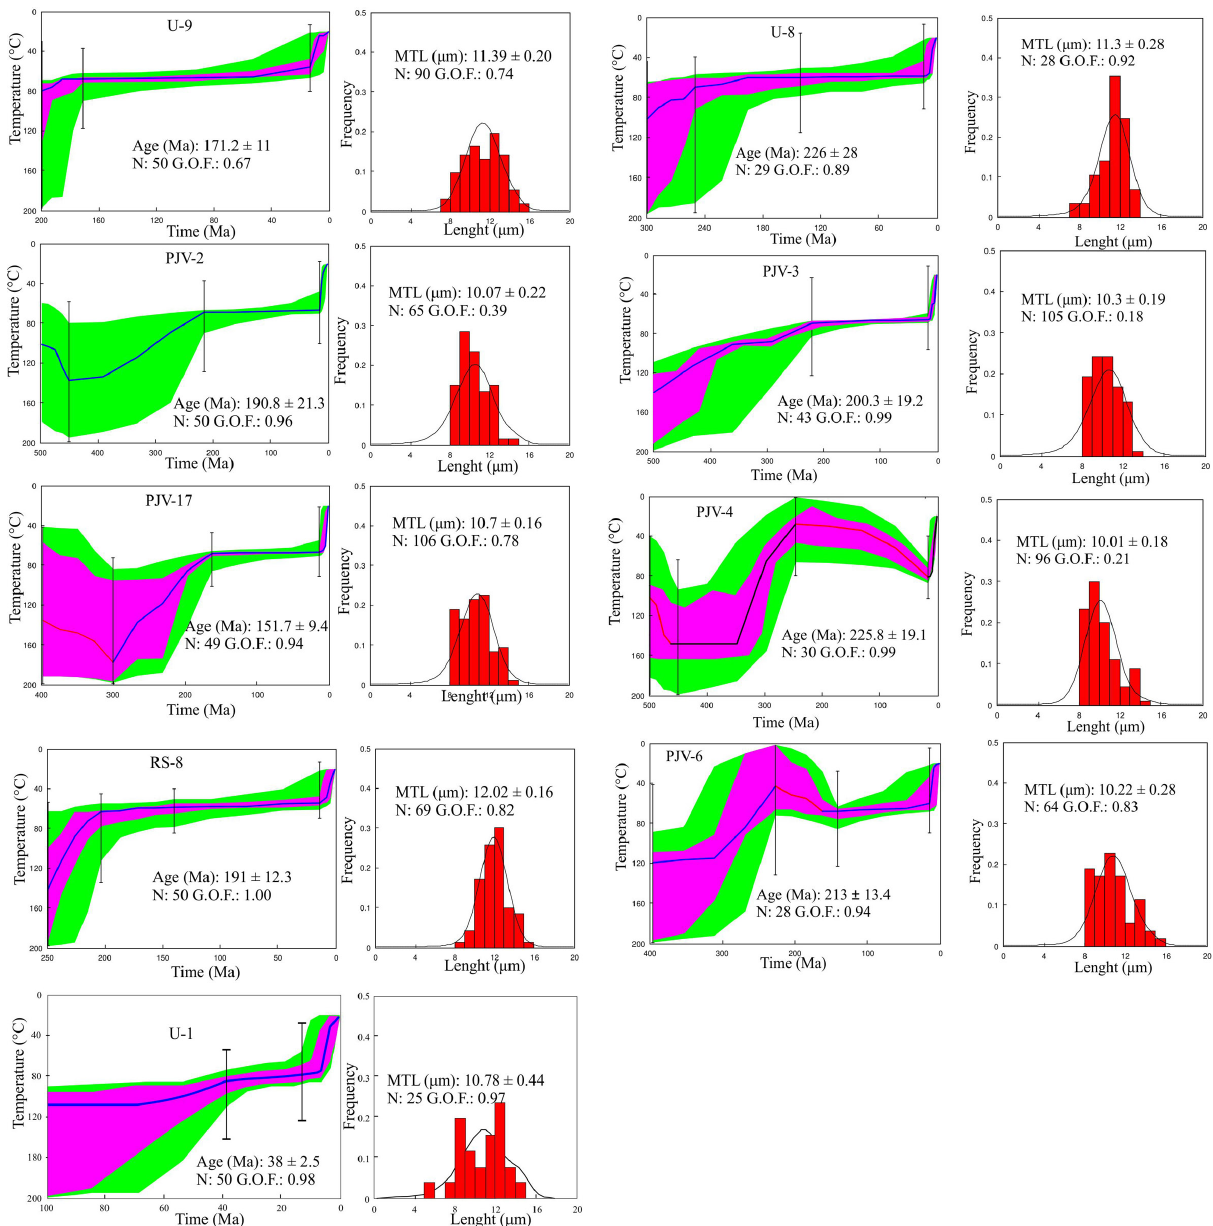
Figure 5. Thermal history of samples from the East Domain. For detailed description see caption of Fig.